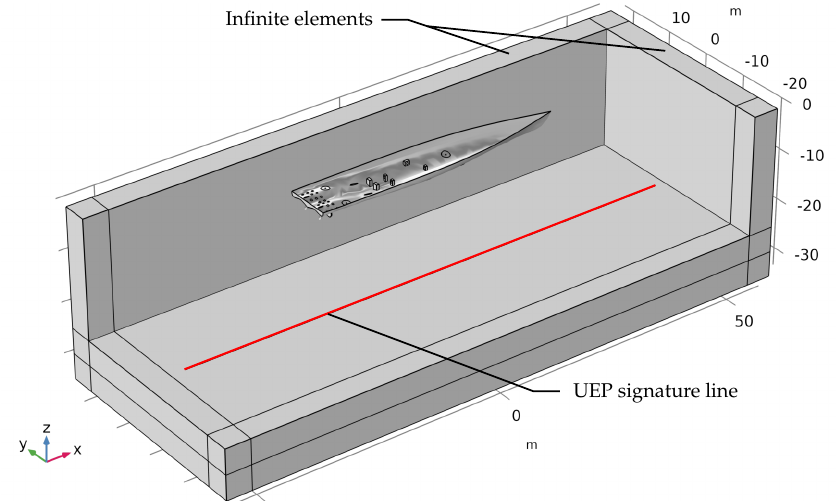
Figure 2. Numerical setup including water domain and seabed domain within COMSOL Multiphysics to calculate the underwater electric potential (UEP) signature of the generic ship model. For extracting the electric signature of the vessel a UEP signature line is positioned midship 20m below the keel. Additionally, all boundaries except the top layer are surrounded by infinite elements to account for a virtually infinite